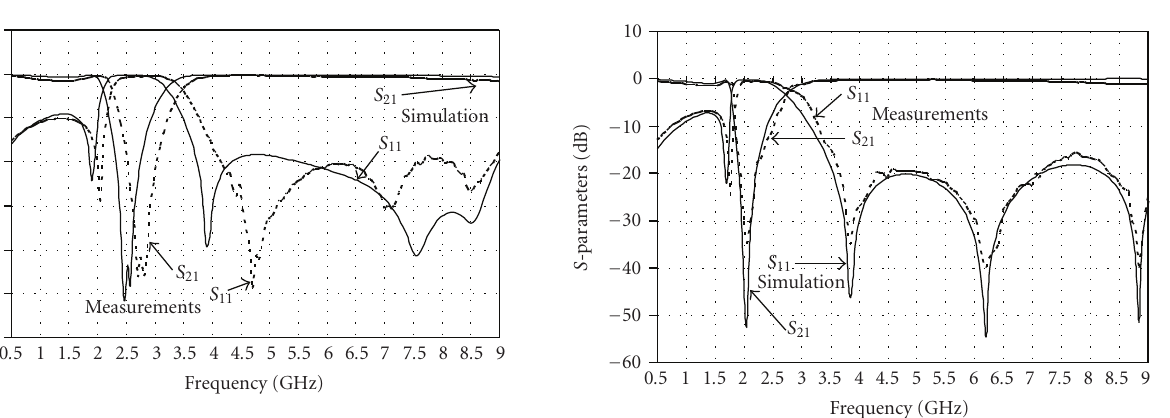
Figure 11: Simulation and measurement results of the shaped stepped impedance bandstop filter.